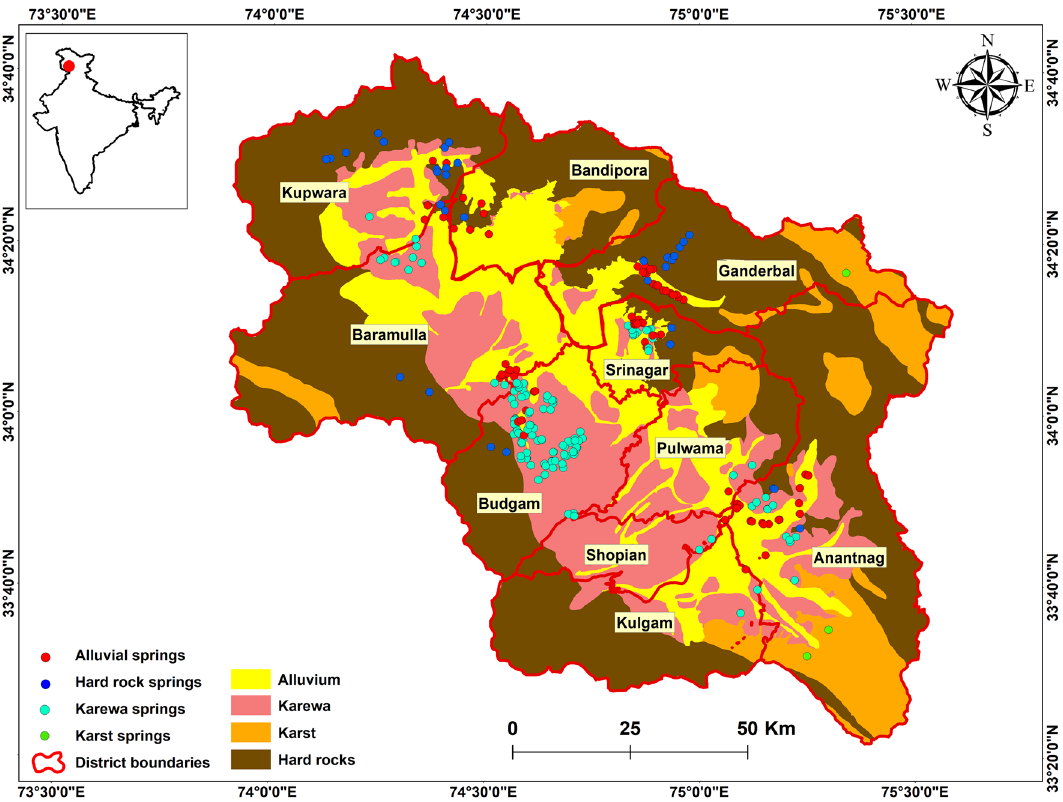
Figure 5. Location of freshwater springs and geological map (Modified after Dar and Zeedan, 2020) 66 of the Kashmir valley. The figure was generated in ArcGIS version 10.4.1. (https:// www. esri. com/ en- us/ arcgis/ produ cts/ arcgis-